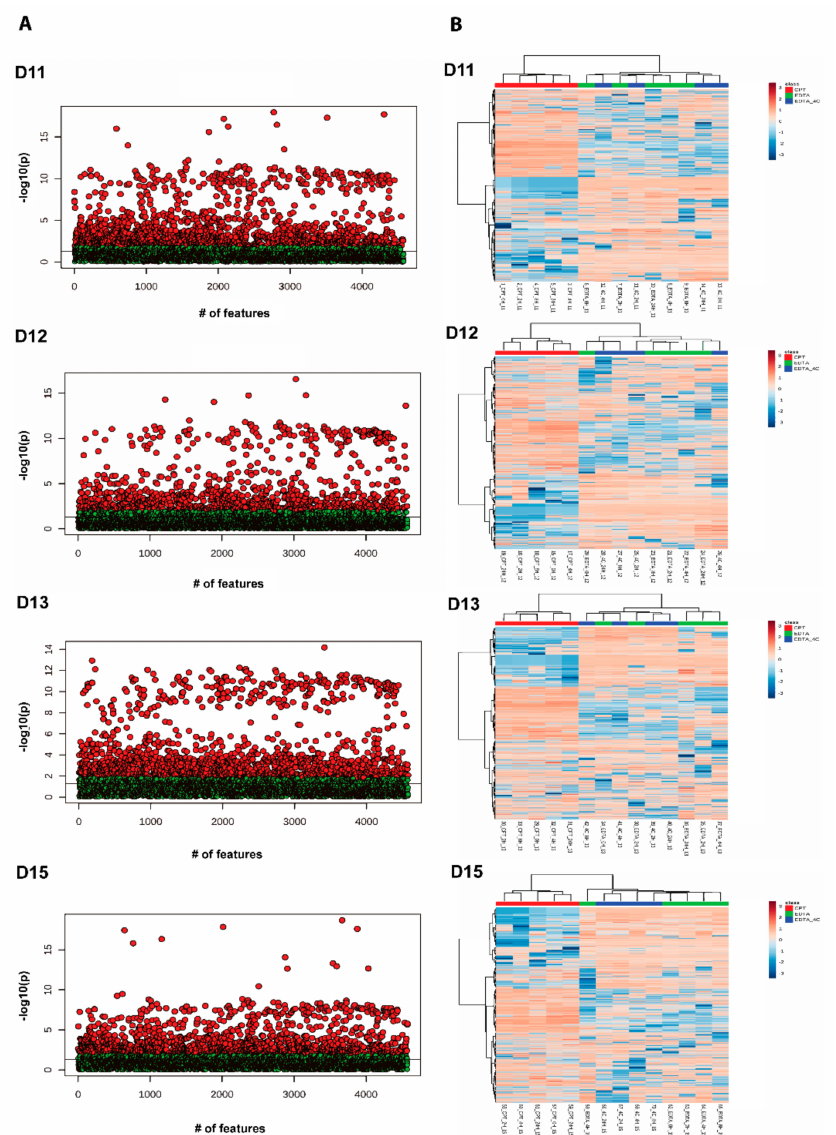
Figure 9. One-way ANOVA analysis of donor-matched metabolomics data. ( A ) Scatterplot showing One-way analysis of variance among donor-matched samples grouped by anticoagulants (red dots show metabolites with p -value < 0.05), ( B ) Two-way hierarchical clustering analysis using Euclidean distance and ward.D clustering algorithm among donor-matched samples grouped by anticoagulants. The heatmap shows overall features from metabolomics data in positive ionization mode that are di ff erent between CPT and EDTA containing tubes. Note: The Y -axis scale of scatter plot is automatically adjusted by Metaboanalyst based on the range of − log10(p). The line on the scatter plot demarcates the − log10(0.05) value on Y